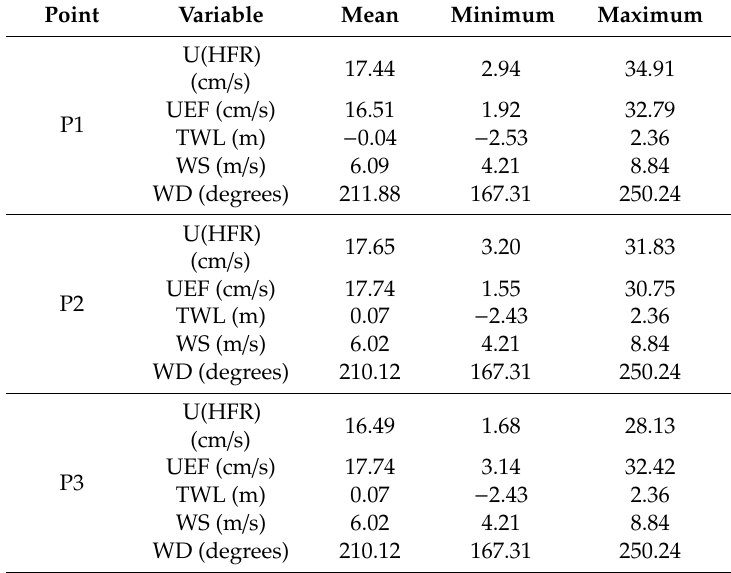
Table 3. Mean and range of prediction dataset (20% of total dataset).